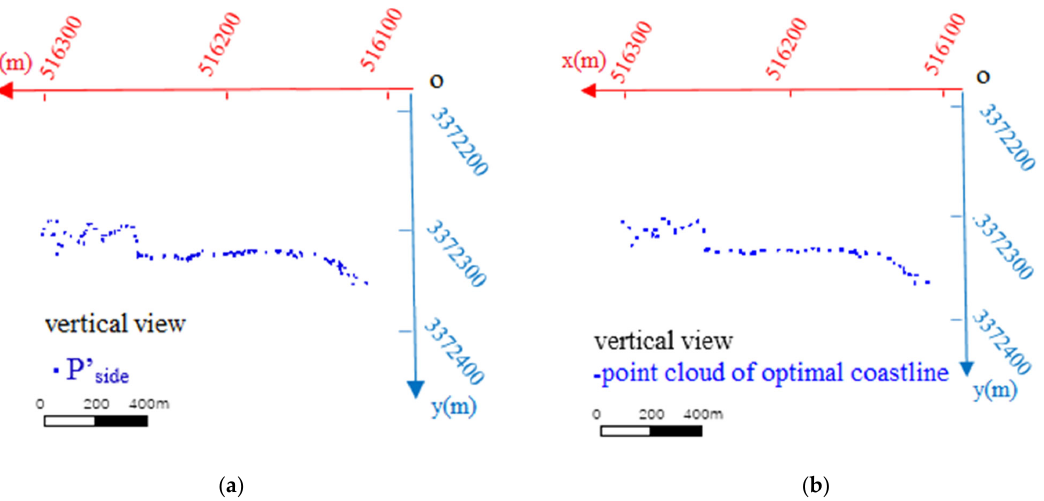
Figure 9. ( a ) Projection point cloud of side points side P ' ; ( b ) Point cloud dataset of optimal coastline. To reflect the relative positional relationship of the point clouds of the optimal coast ‐ line, centroid, and cliff, three ‐ point cloud datasets were superimposed and are displayed in Figure 10a. The elevation of the optimal coastline points was closer to that of the water body, and their spatial height was closer to the water surface. Figure 10b shows an en ‐ larged view of the red box in Figure 10a. ( a ) ( b ) Figure 10. ( a ) Superposition of point cloud of optimal coastline and centroid and point cloud at cliff; ( b ) The enlarged view of the red box in Figure ( a ). As the coastline of the cliff is only a small segment, it must be fused with the point cloud of the coastline outside the cliff. According to the boundary point cloud of data extracted in the previous step, the coastline of the entire sea area could be obtained by replacing the point cloud of the cliff segment with the point cloud of the optimal coastline. To depict the difference between the point cloud of the merged coastline and that of the original boundary, these datasets were superimposed and are displayed in Figure 11a. The red segment and arched point cloud in the figure represent the point cloud dataset of